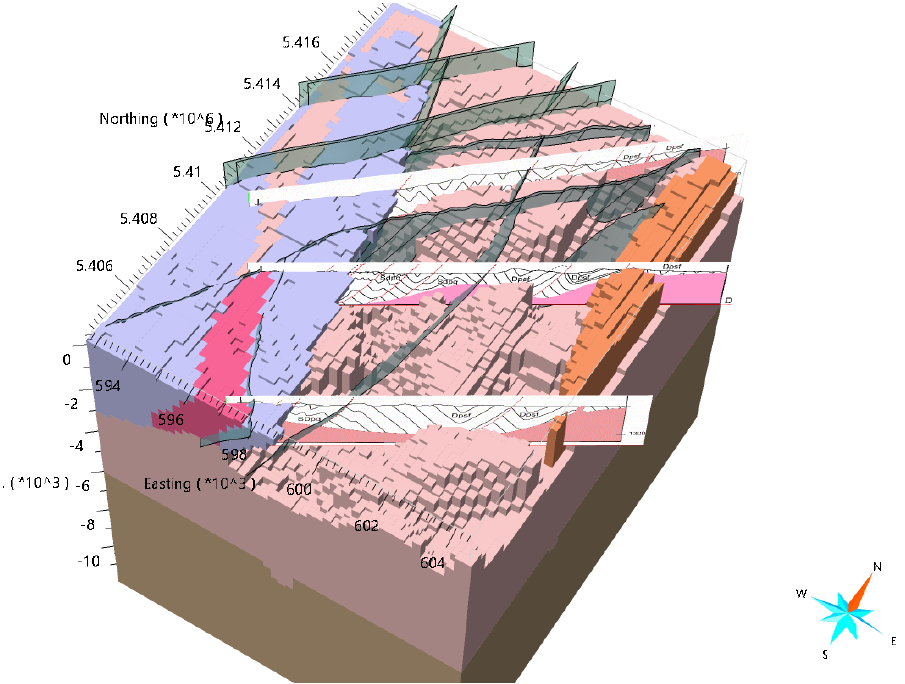
Figure 23. Discretized voxet reference model of the Scamander 3D model illustrating interpretative cross-sections, granite surface (pink), and fault network (transparent turquoise grey). Table 3. Eastern Terrane existing and model-informed mean density (kg ∕ m 3 ).